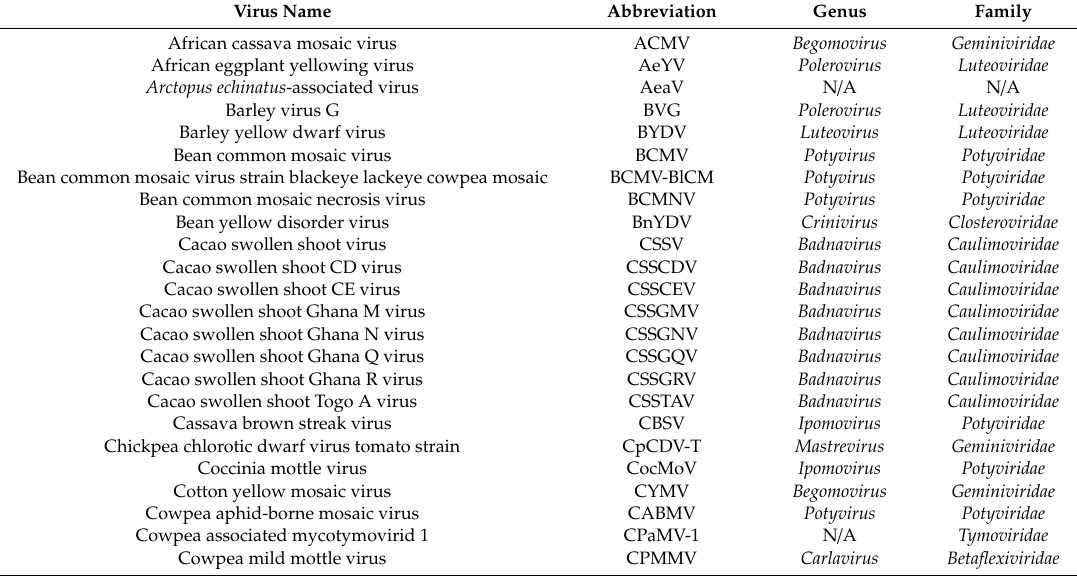
Table 1. Names, abbreviations and taxonomic status of viruses identified in Africa by HTS